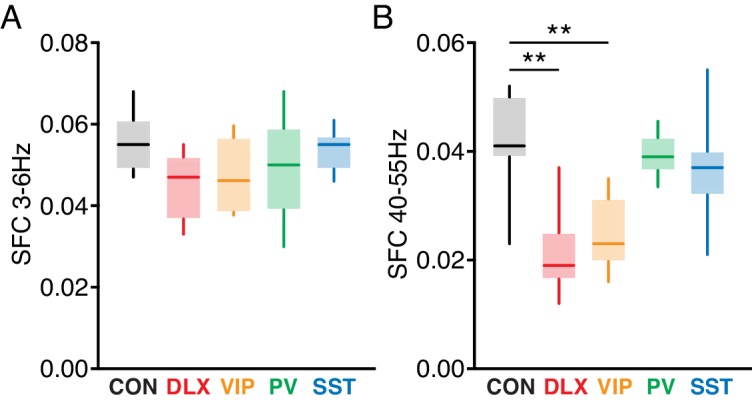
Alteration in the temporal pattern of spiking.(A) Mean spike-field coherence (SFC) in the 3–6 Hz band for units recorded in Mecp2f/y controls (n = 7) and in Dlx5/6 (n = 5), VIP (n = 5), PV (n = 5), and SST (n = 7) mutants. (B) Mean SFC in the 40–55 Hz band. **, p<0.01.